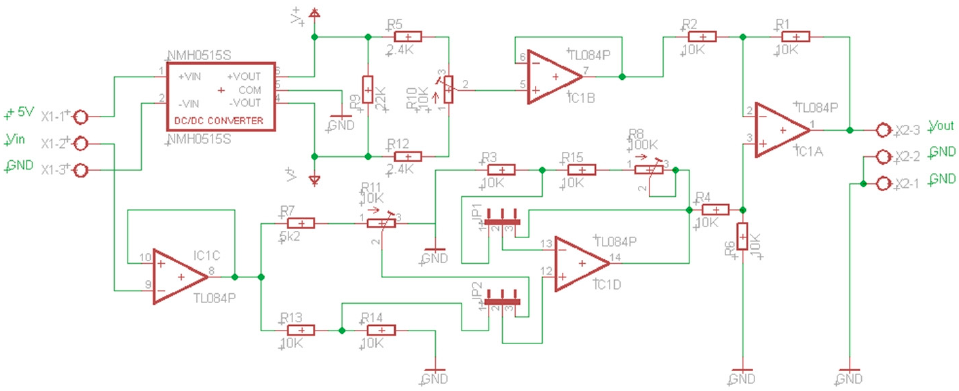
Figure 5. MCLAL circuit from 0/10 V to − 10/10 V or, in general, to –V/+V.